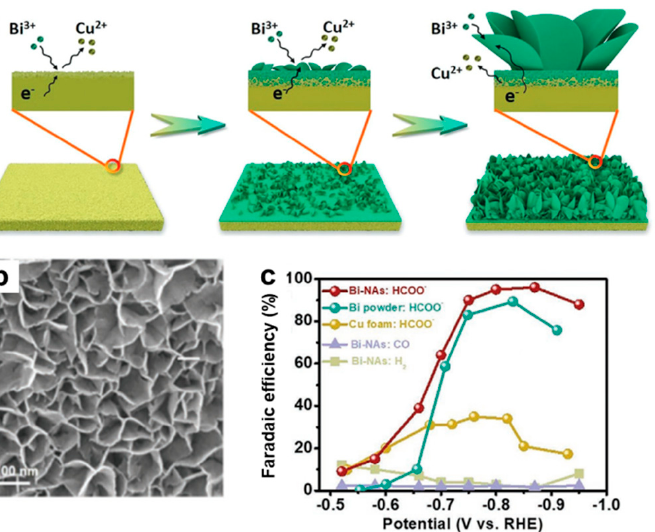
Figure 8. ( a ) Schematic diagram of the synthesis and ( b ) morphology of Bi nanosheets synthesized by galvanic replacement reaction; ( c ) Comparison of potential–dependent FE for HCOO − , CO, and H 2 measured on Bi nanosheets (Bi–NAs), Bi powders and Cu foam. Reproduced with permission [71]. Copyright 2021, Wiley–VCH.